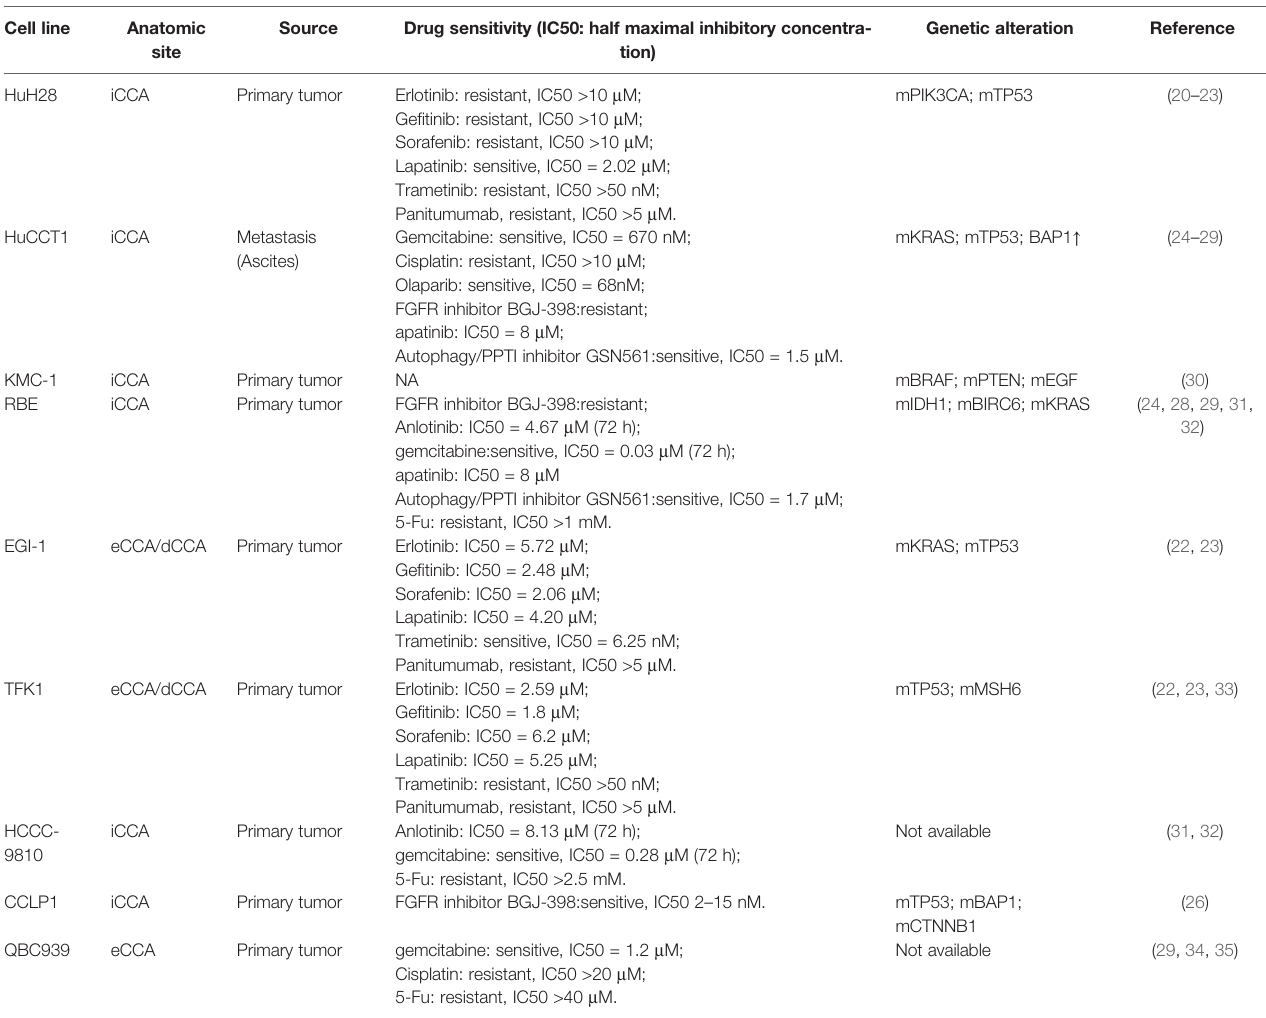
TABLE 1 | The most frequently used CCA cell lines and their